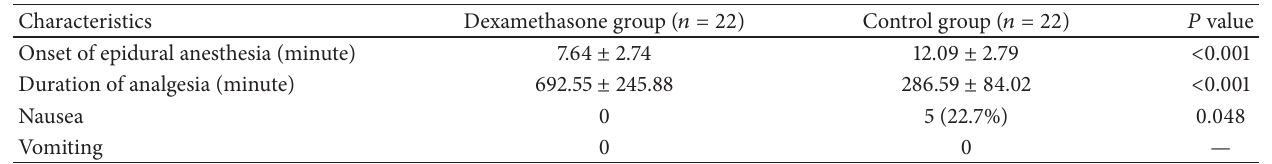
Table 2: Clinical variables in two